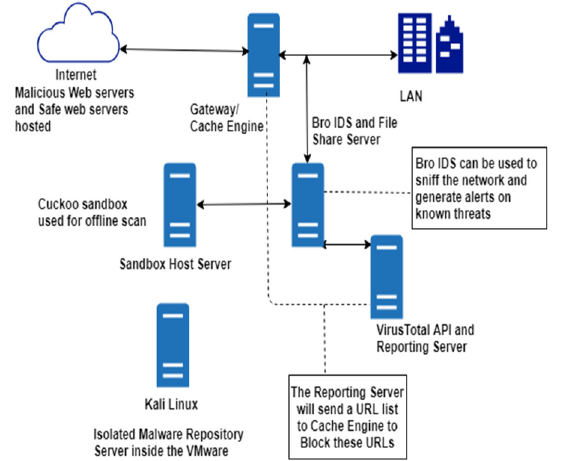
Fig. 1: Architecture of Malicious Servers Detection Schema for Preventing Client-Side